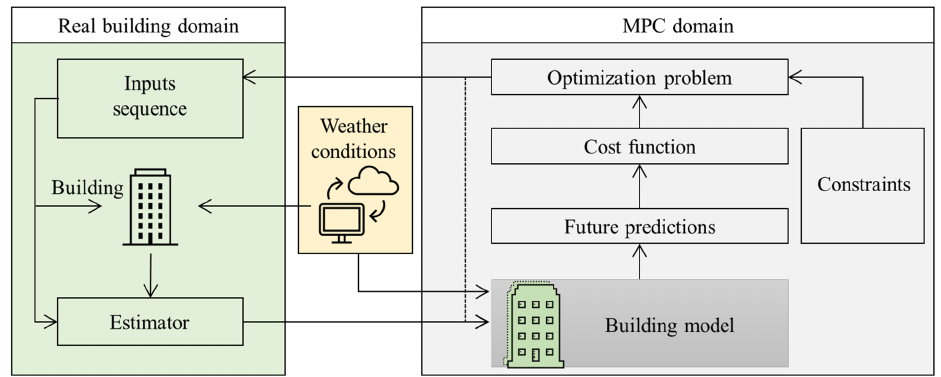
Figure 6. Schematic of the standard control-loop system for MPC-based building control, based on Ref. [21].